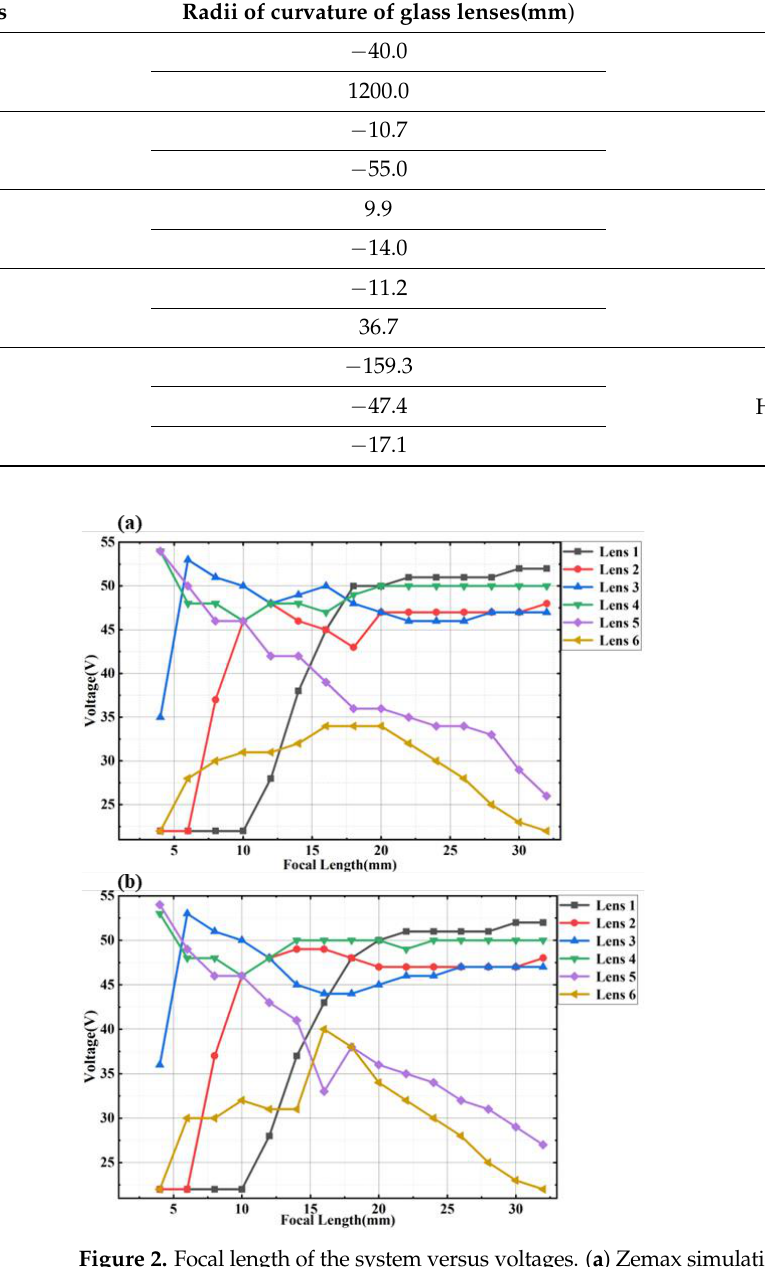
Figure 2. Focal length of the system versus voltages. ( a ) Zemax simulation data. ( b ) Experimental data. Table 1. Radii of curvature of liquid lenses and glass lenses at different focal lengths and the mate- rials of glass lenses.